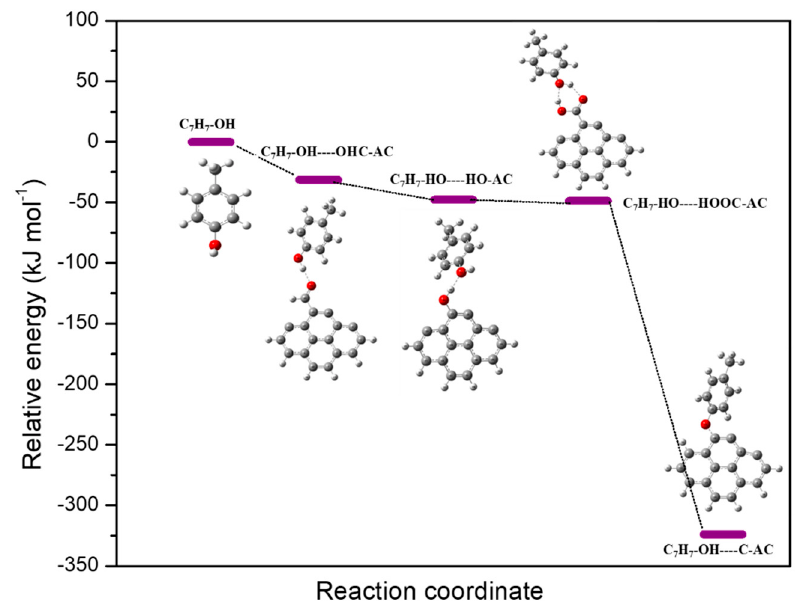
Figure 3. Relative energy diagram of adsorption of cresol onto pristine and functionalized activated